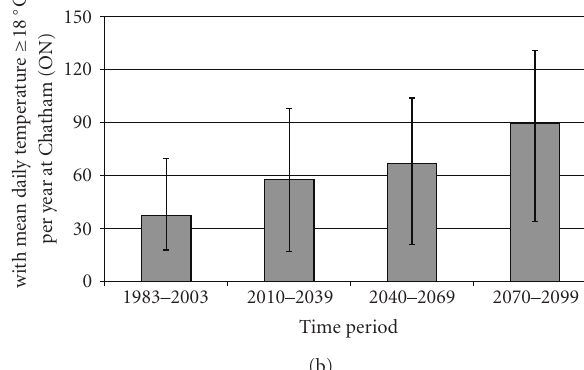
Figure 3: (a) Annual number of consecutive days ≥ 18 ◦ C, Toronto. Bars indicate the number of consecutive days per year that temperatures ≥ 18 ◦ C. A trendline (solid line) shows the 10-year moving average for the data. The trendline suggests that in the last few years, we have begun to experience su ffi ciently prolonged summer warm periods to support parasite replication and malaria transmission potential. In 2002 and 2005, the number of days above 18 ◦ C was su ffi cient to support 2 cycles of P. vivax replication. These data should be considered conservative since each degree-day ≥ 18 ◦ C will reduce the remaining time required for parasite replication. Additionally, breaks in consecutive warm days ≥ 18 ◦ C do not necessarily prohibit continued development once temperatures rise [35]. Source of climate data: Environment Canada [46]. (b) Annual number of consecutive days ≥ 18 ◦ C projected for 2010–2099, Chatham (ON). Bars indicate the number of consecutive days per year that temperatures are projected to reach or exceed 18 ◦ C. Error bars indicate the range of values during each time period. The climate change projections were obtained from interpolation (for Chatham, Ontario) of output from the CGCM2 (Canadian Coupled Global Climate Model 2) [47] that were downscaled using LARS-WG stochastic weather generator. LARS-WG was calibrated with 30 years of daily weather observations at Chatham (and its predecessors) obtained from the Environment Canada database. The output used here was obtained using emissions scenario A2 (business as usual). The data and methodology used here are the same as described in Ogden et al. [49]. The projected trend shown here indicates increasingly extended summer warm periods su ffi cient to support multiple parasite replication